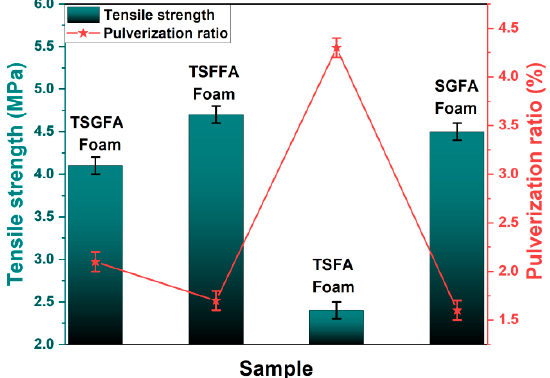
Figure 3. Pulverization ratio and tensile strength data of the various foams.